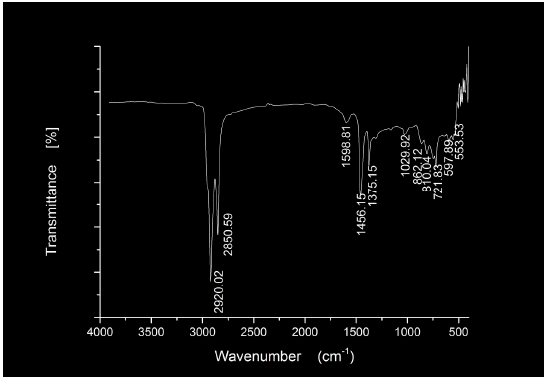
Figure 5. FTIR spectra of the BA materials.